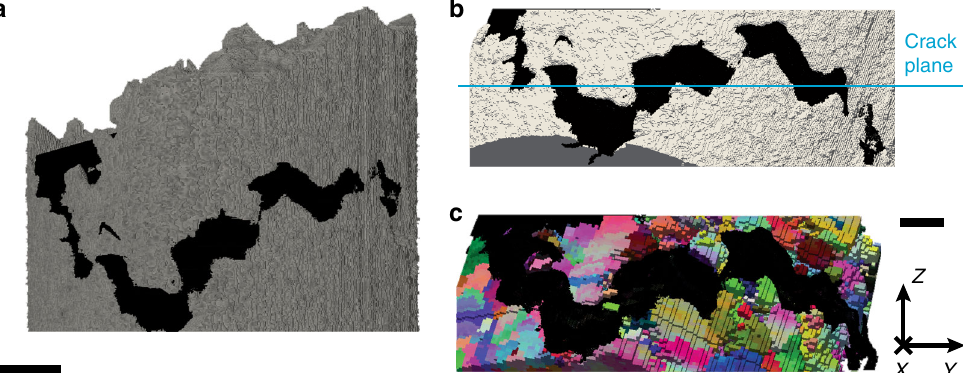
Fig. 1 3D sample reconstruction. a X-ray attenuation tomography (XRAT) data with metal shown in gray and void space inside the secondary crack shown in black. Scale bar: 200 μ m. b Isolated section of the XRAT reconstruction with an edge-on view of the nominal crack plane ( X – Y ), indicated in blue. The nominal crack propagation direction ( X ) is into the page. c High-energy diffraction microscopy (HEDM) reconstruction of the microstructure viewed from the same direction as b . Each voxel is colored according to the crystallographic orientation of the crystal at that location relative to the laboratory reference frame. Scale bar for b and c : 100 μ m. The black void space indicating the space inside the crack was obtained from the XRAT reconstruction and digitally fused with the